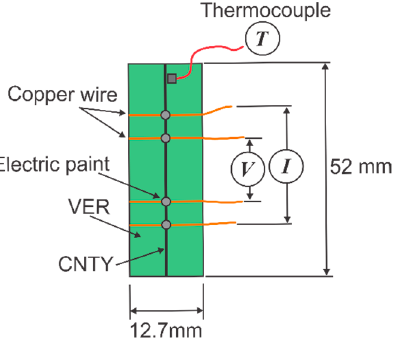
Figure 2. Schematic depicting the experimental setup of in situ electrical measurements and di- mensions.